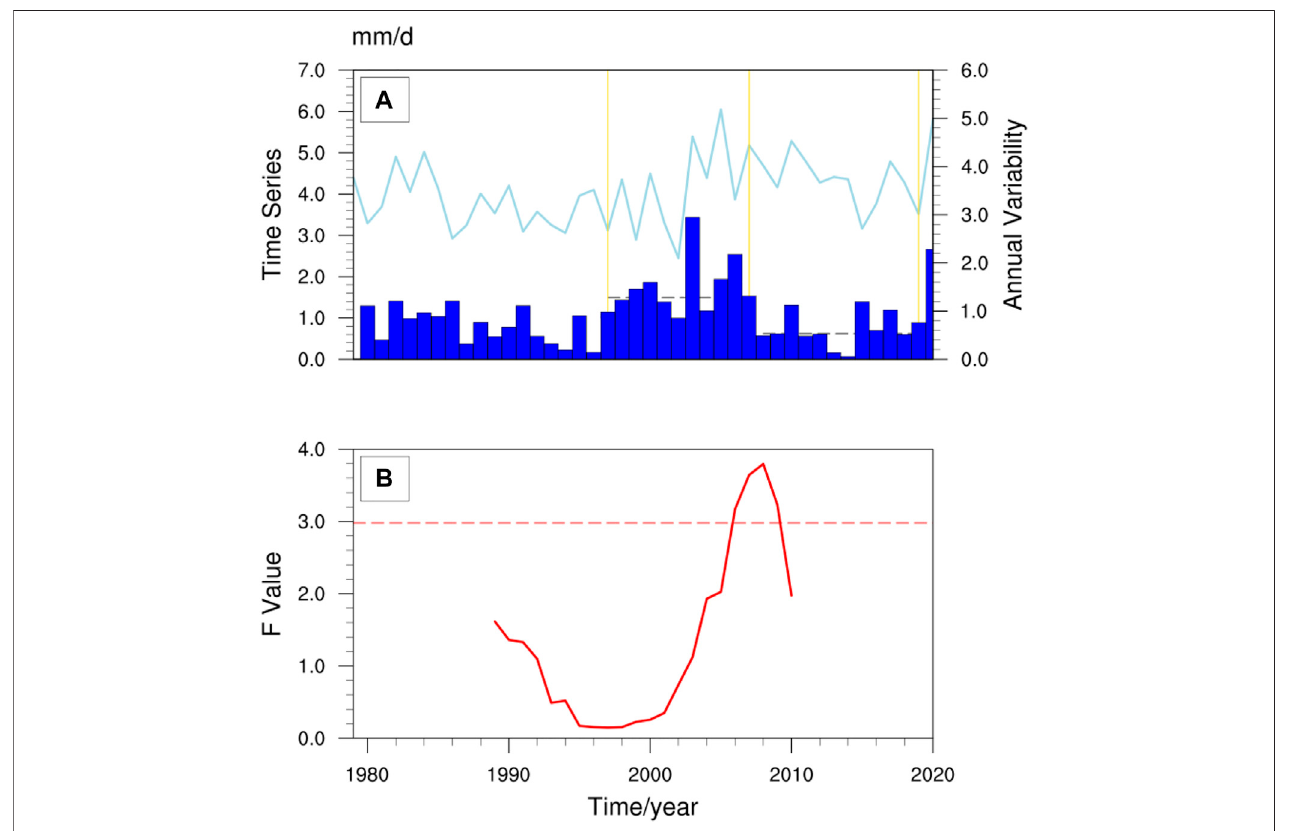
FIGURE1|(A) Timeseries(bluesolidline)andabsolutevaluesofannualincrement(bluebars)and (B) 10-yearrunningFtestvalues(redsolidline)ofsummerrainfall over the YHRV [dash lines in (A) represent mean values of annual increment in P1 and P2, respectively; dash line in (B) indicates signi fi cant values exceeding the 95% con fi dence